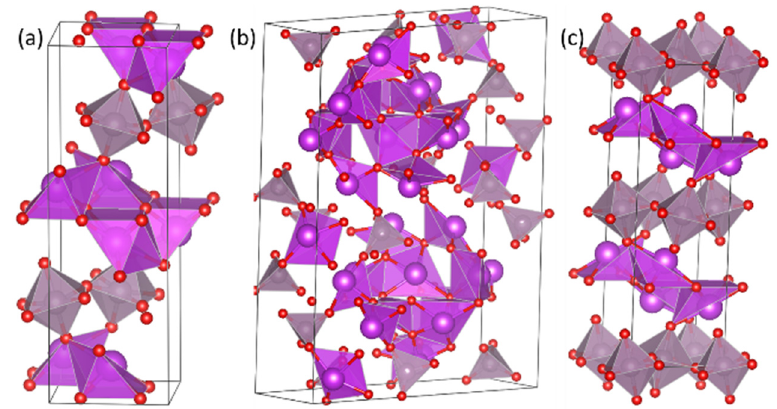
Figure 1. Polyhedral representation of ( a ) orthorhombic Pca2 1 , ( b ) monoclinic p21/c, and ( c ) orthorhombic Pbca structures of Bi 2 MoO 6 . Purple spheres are Bi, grey Mo, and red O.